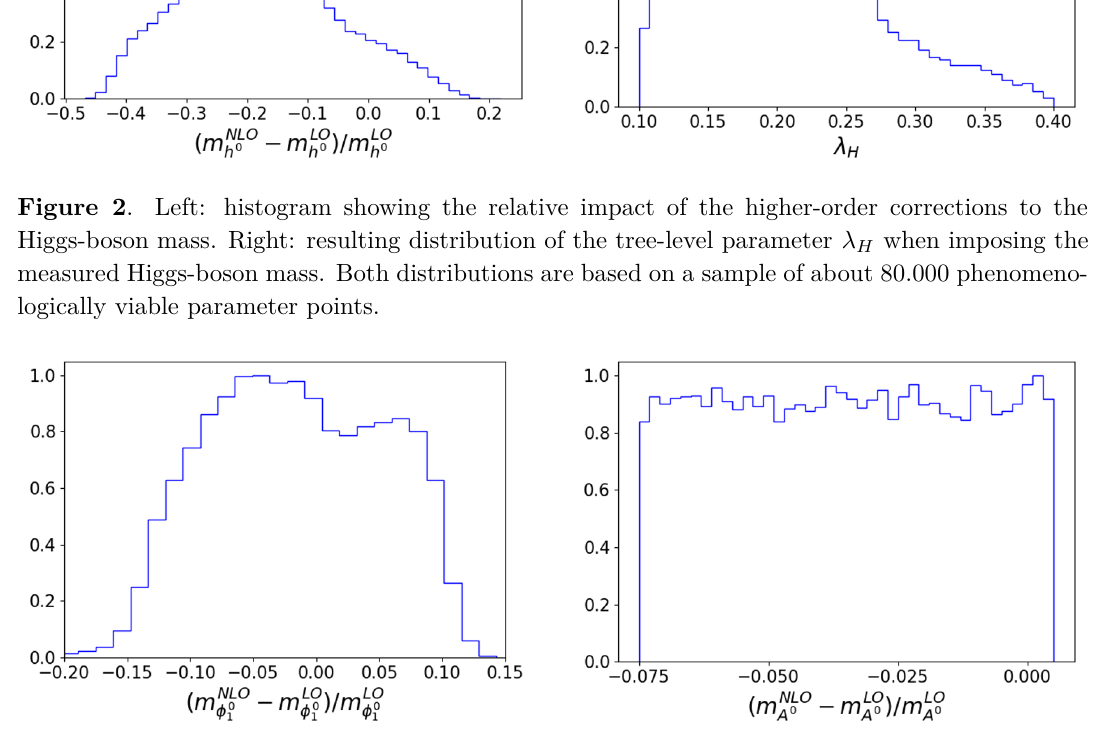
Figure 3 . Histograms showing the relative impact of the higher-order corrections for the lighter scalar ( m , left) and the pseudo-scalar ( m 0 φ 0 1 figure